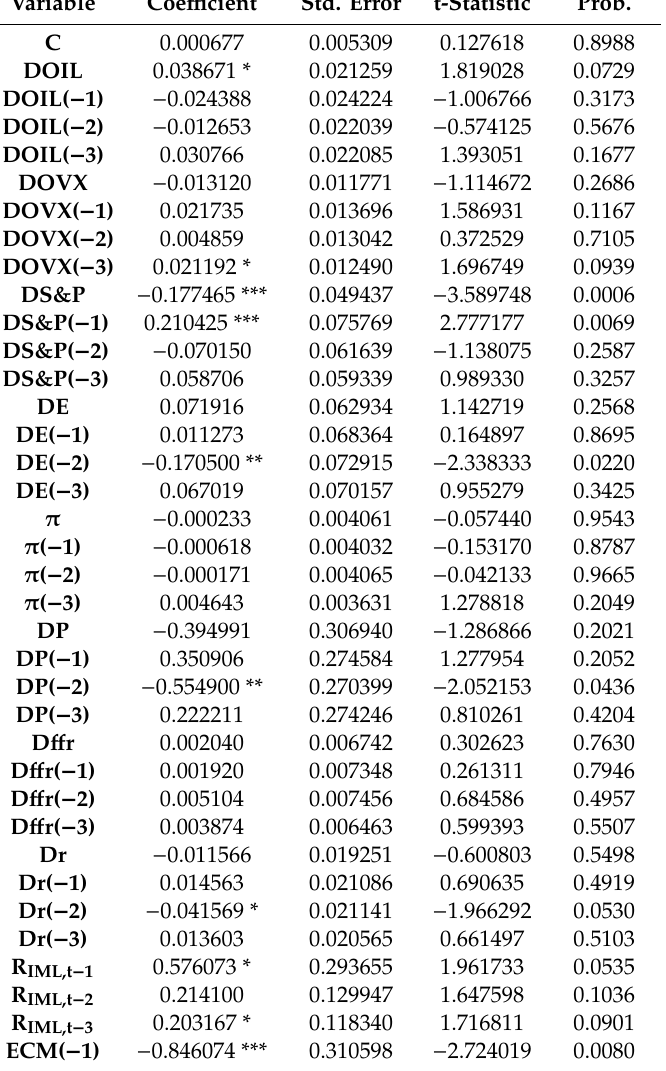
Table 22. Short-run error correction model